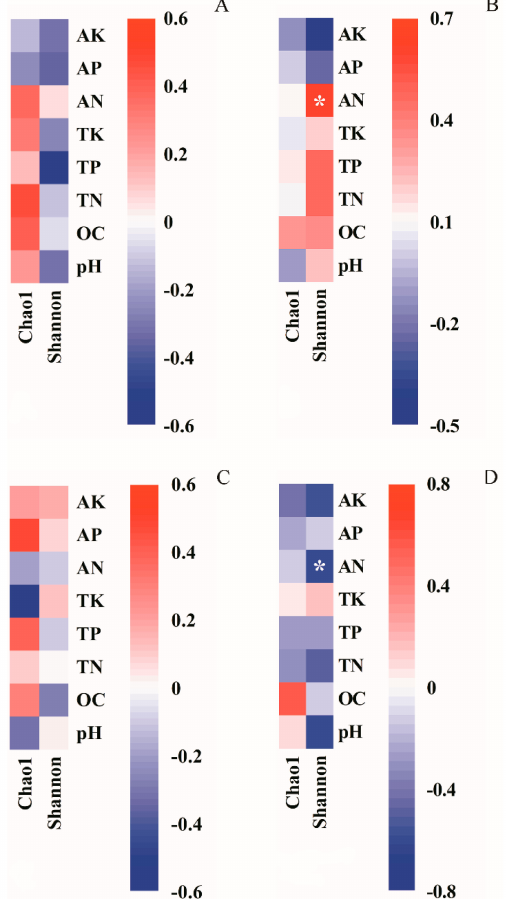
Figure 3. The relationships of microbial alpha diversity and chemical properties of the soil. ( A ) The relationships of fungal diversity and chemical properties in bulk soil. ( B ) The relationships of bacterial diversity and chemical properties in bulk soil. ( C ) The relationships of fungal diversity and chemical properties in rhizosphere soil. ( D ) The relationships of bacterial diversity and chemical properties in rhizosphere soil. The numbers on the right stand for the relationships between the diversity indexes and chemical properties of the soils based on the Pearson’s correlation analyses. Asterisks denote significant relationships between the microbial diversity indexes and the chemical properties (* p <